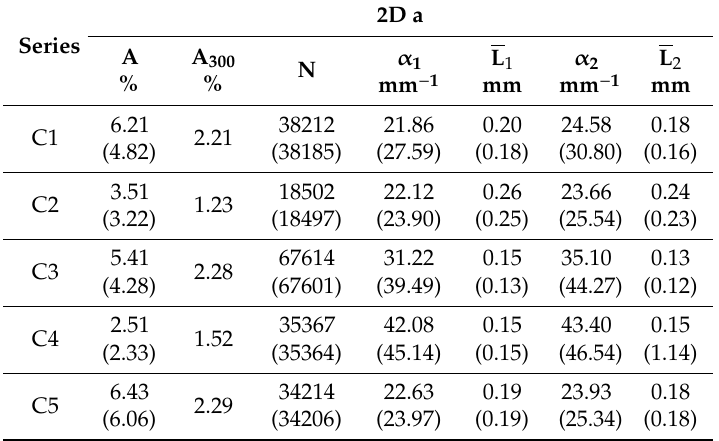
Table 4. Results of air void parameter assessment with 2D with automatic separation of connected air